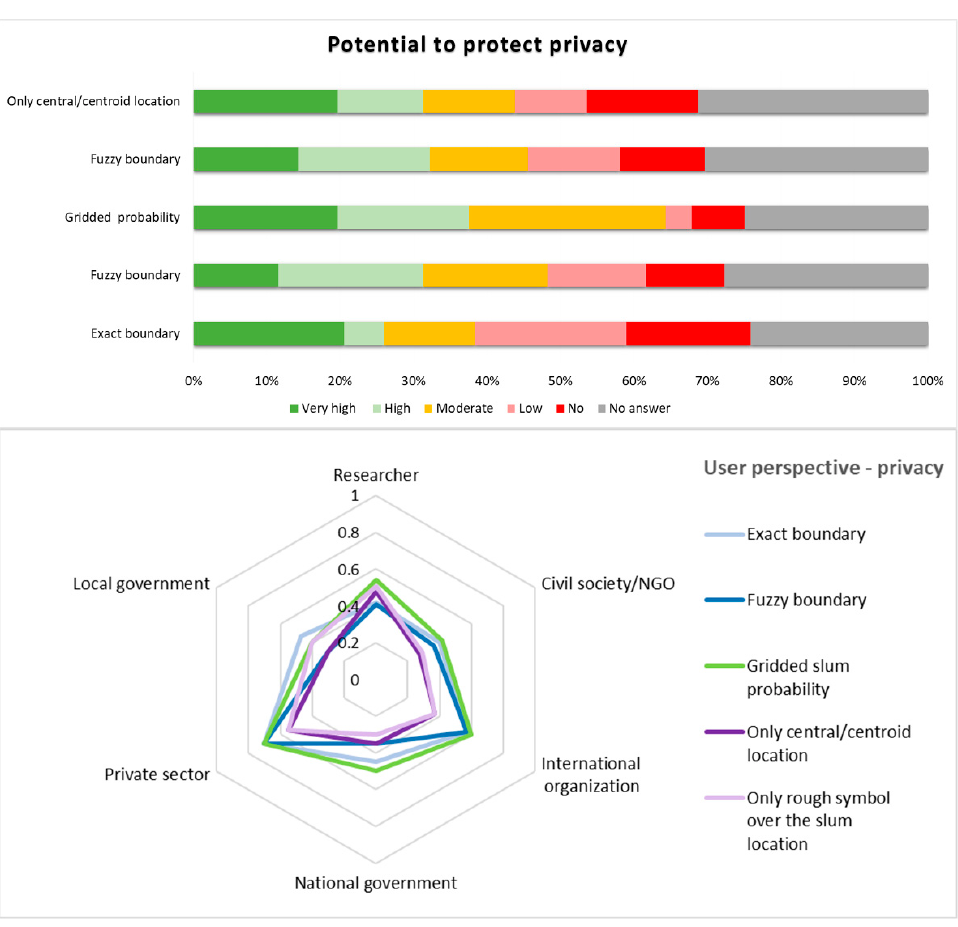
Figure 16. Results of the online expert survey, potential of data aggregation to protect privacy (in %) (N = 112) (upper), user group preference scores of aggregation levels (1 = high preference and 0 = no preference) (lower).